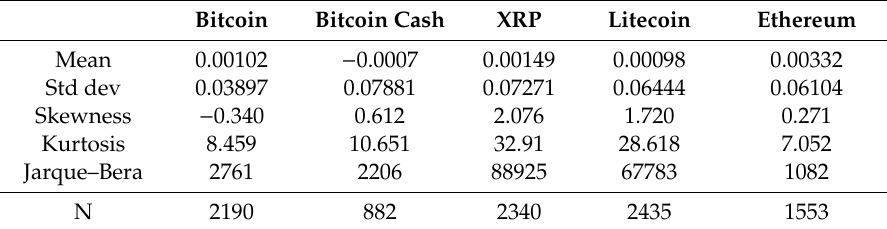
Figure 3. Plot of Time Series. Plot of closing prices for Bitcoin, Bitcoin Cash, Ethereum, Litecoin, and XRP. Table 2. Summary Statistics. The table reports the summary statistics for the cryptocurrencies in the